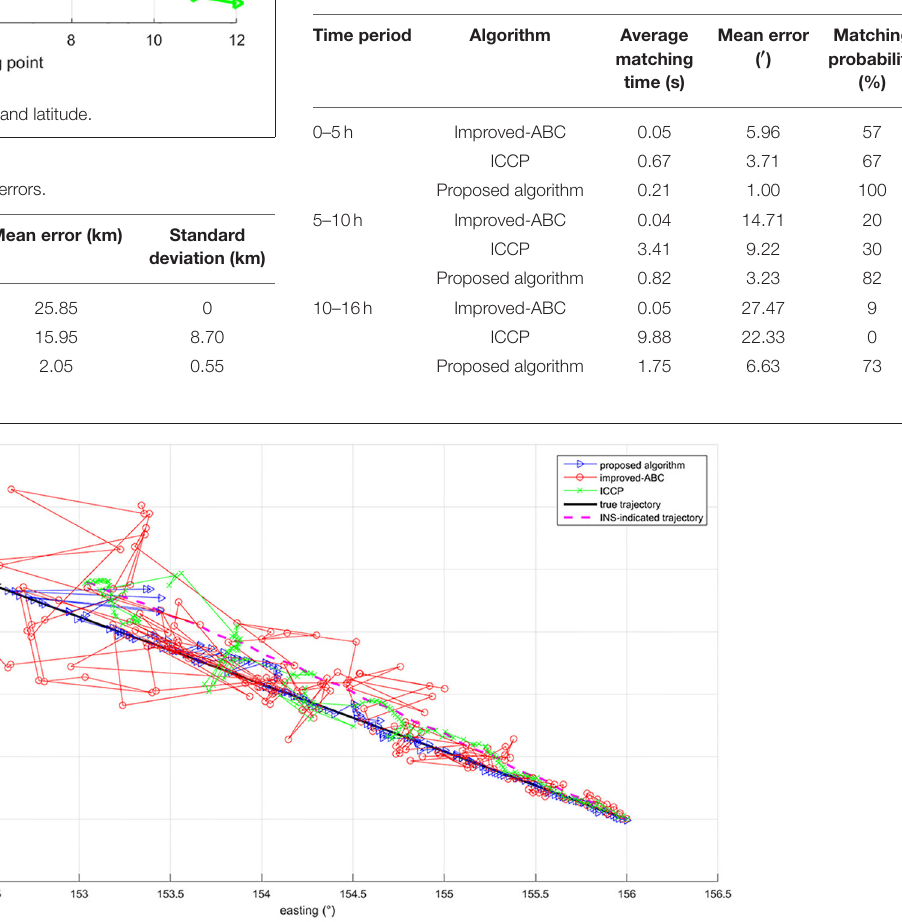
TABLE 6 | Statistical results within 16h.